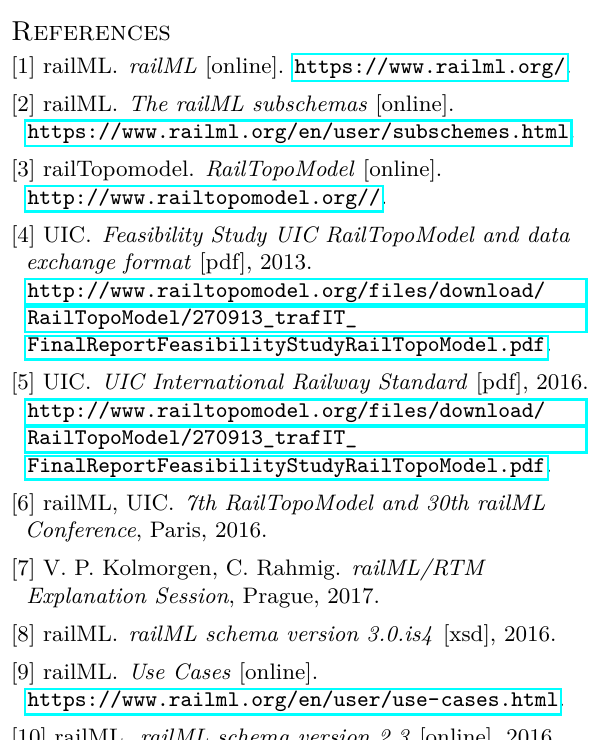
Figure 3. An author’s proposal of RailTopoModel application in the scope of passenger routing issue exemplified for the case of a railway station equipped with platforms with level